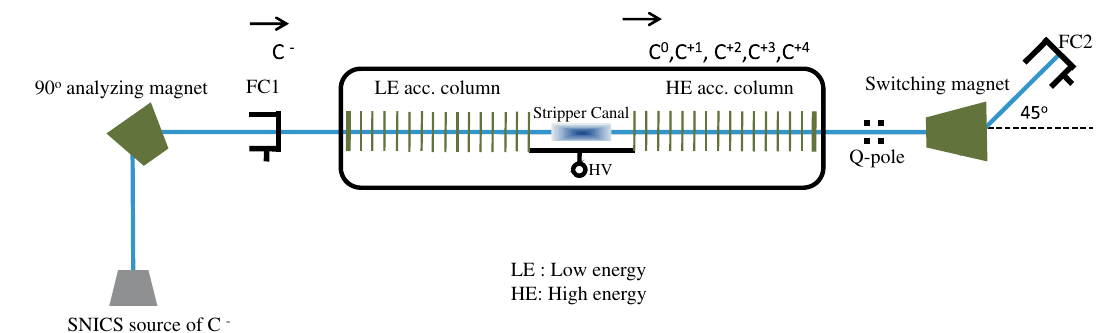
FIG. 1. The schematic diagram of the experimental setup. FC1 and FC2 are the two Faraday cups used to measure the currents of the incident and the outgoing beam,